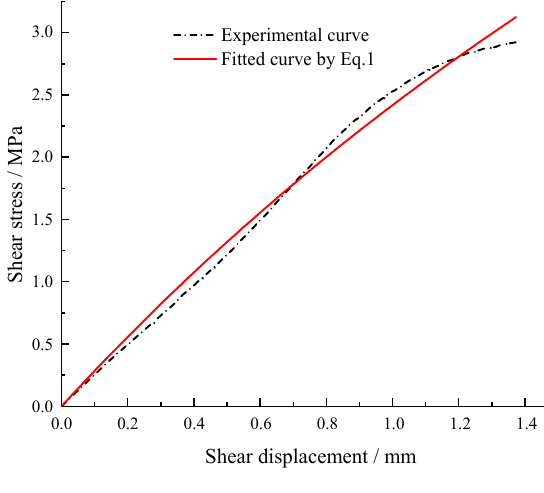
Experimental curve Experimental curve Fitted curve by Eq.1 Fitted curve by Eq.1